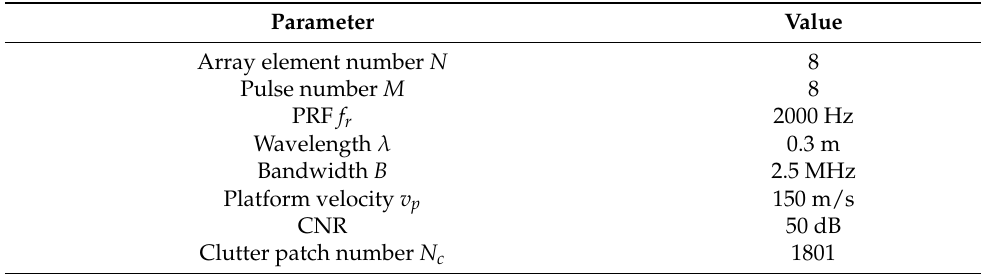
Table 2. Simulation